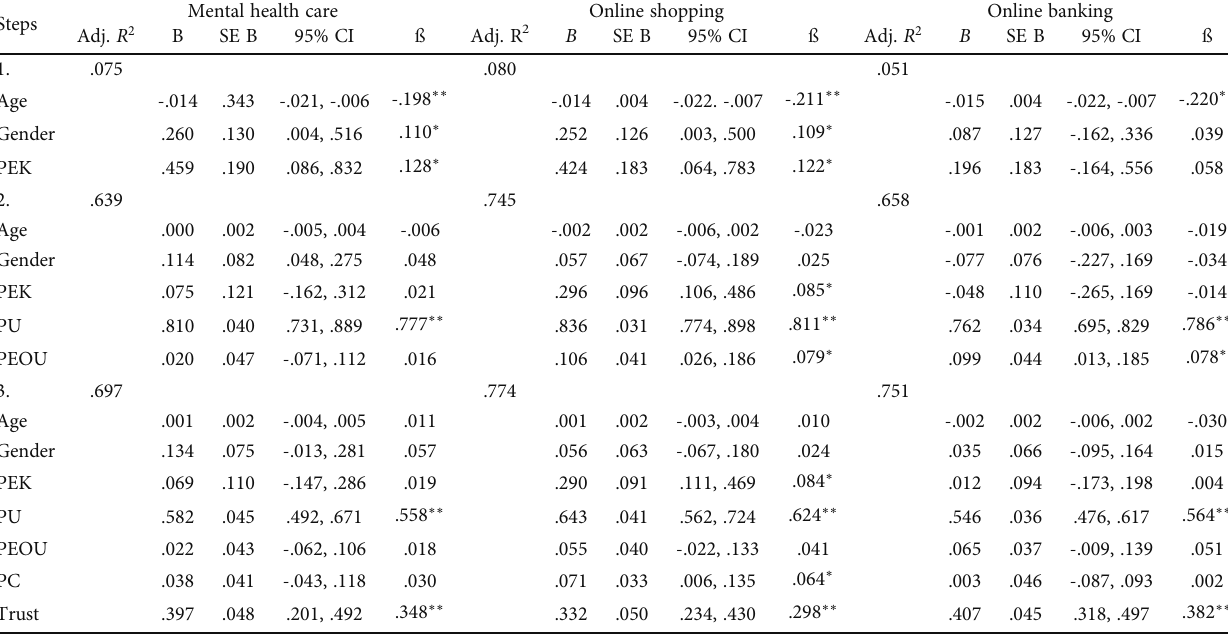
Table 5: Regression analysis of predictors of behavioural intentions to use AI chatbots for mental health care, online shopping, and online banking in